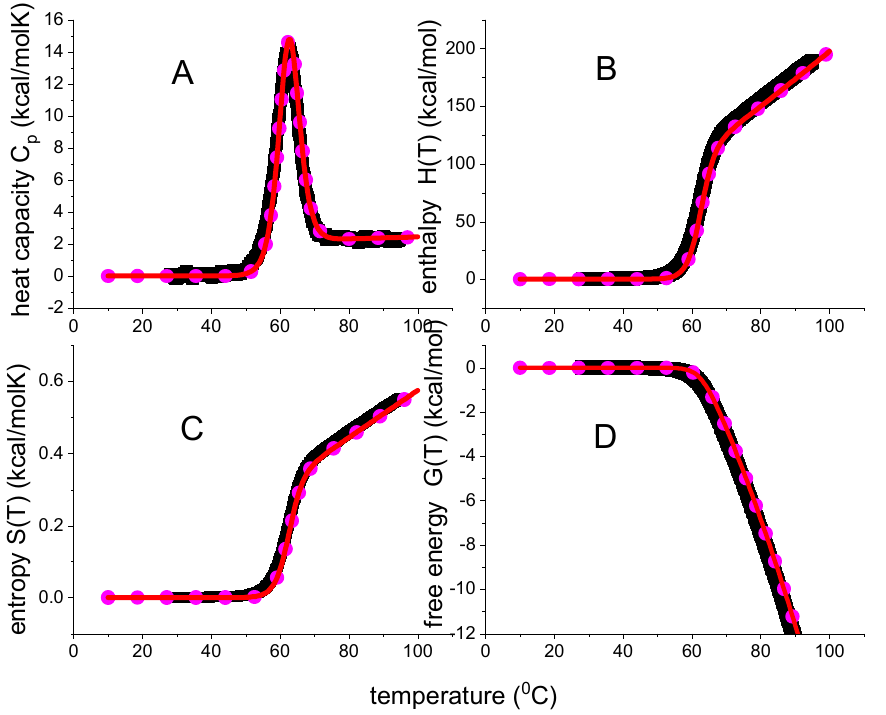
Figure 6. Analysis of lysozyme heat unfolding with 2-state models. Black data points: DSC